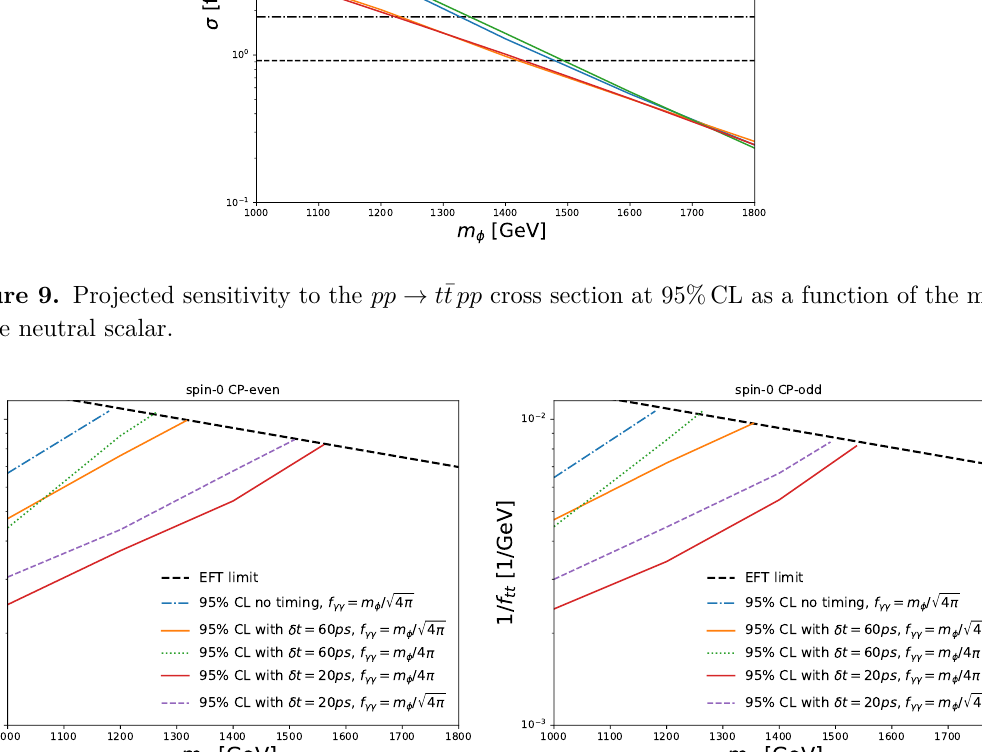
Figure 10. Projected sensitivity at 95% CL in the ( m φ − f − 1 sensitive to our pp → t ¯ t pp